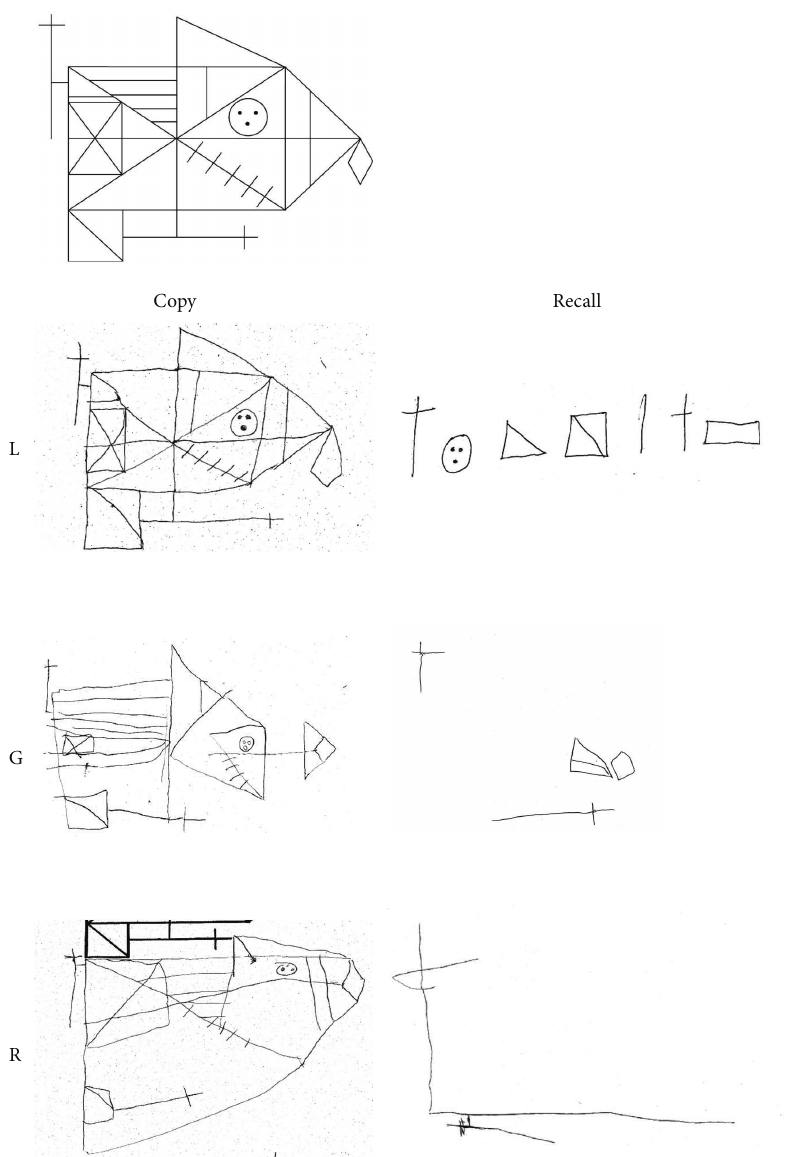
Figure 2: Rey’s figure: copy and recall after a 15-minute delay performed by L., G., and R. The good copy realized by L. required a very slow process, beginning with the triangle-rectangle at the left top of the figure and adding segment by segment until the end. G. reproduced some details with general spatial contiguity. R. closed in on model and showed difficulties in drawing both details and global shape. All children had poor recall: L. could recall local details but failed to integrate them into an integrated whole, whereas G. and R. drawings were limited to very few details.